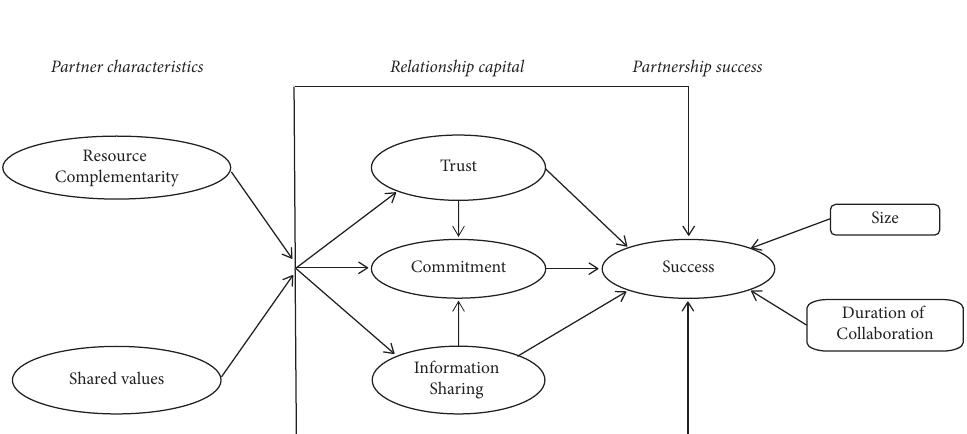
Figure 2: Research model.